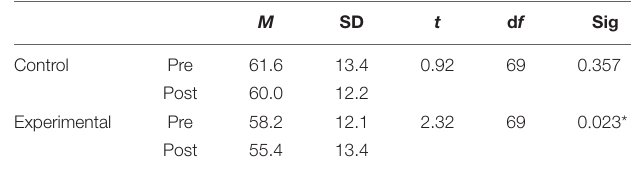
TABLE 1 | English Language Learning Anxiety Scale (ELLAS) independent samples T -test results.